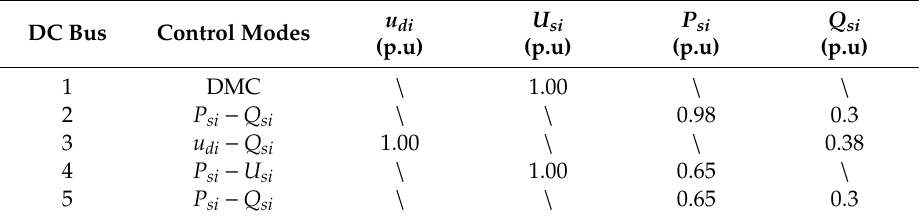
Figure 6. The modified IEEE-118 bus system with a VSC-MTDC system. Table 1. Control modes of VSCs.